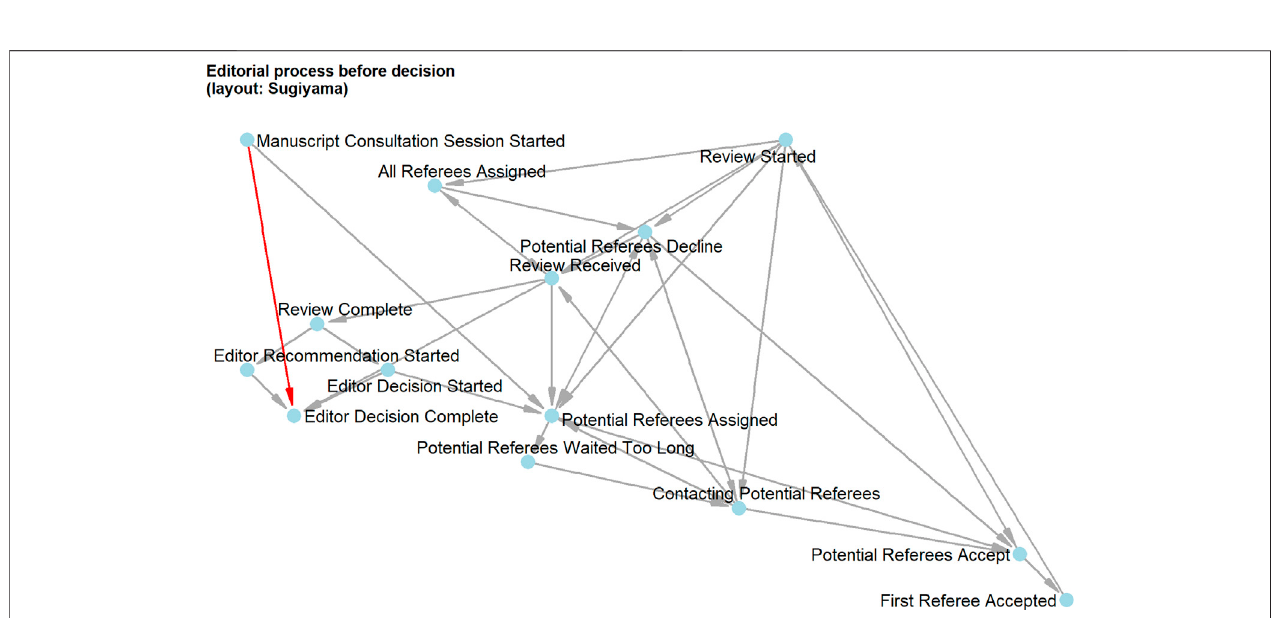
FIGURE 5 | From the start of manuscript consultation until the editor ’ s decision: The fi gure shows that there is a short way (red) without external consultation and the long and complex way with external reviewers (grey).